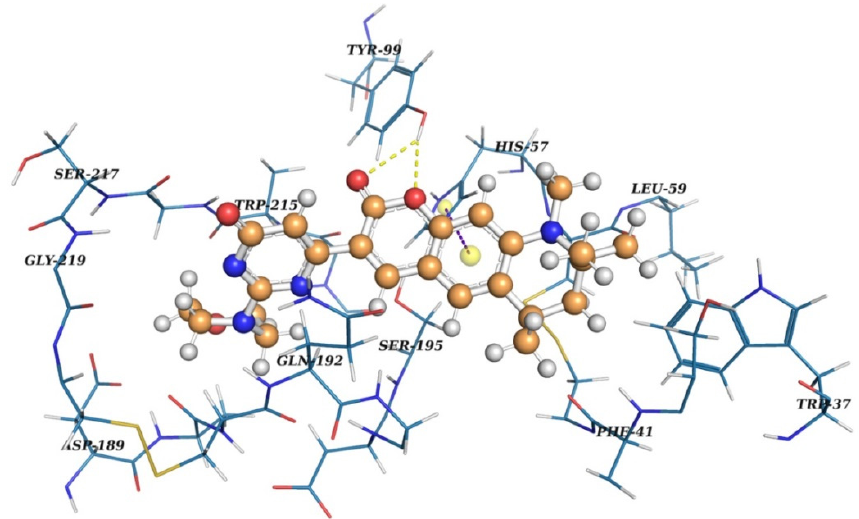
Figure 7. Binding mode of compound 225006 with factor XIIa predicted by docking. A pose after local optimization in PM7 is used. Interactions are predicted by PLIP. H-bonds are shown as dashed yellow lines. A dashed blue line indicates pi-stacking. The ligand is presented in a ‘ball-and-stick’ model and colored in orange. Protein residues are shown in a ‘line’ model and colored in marine.